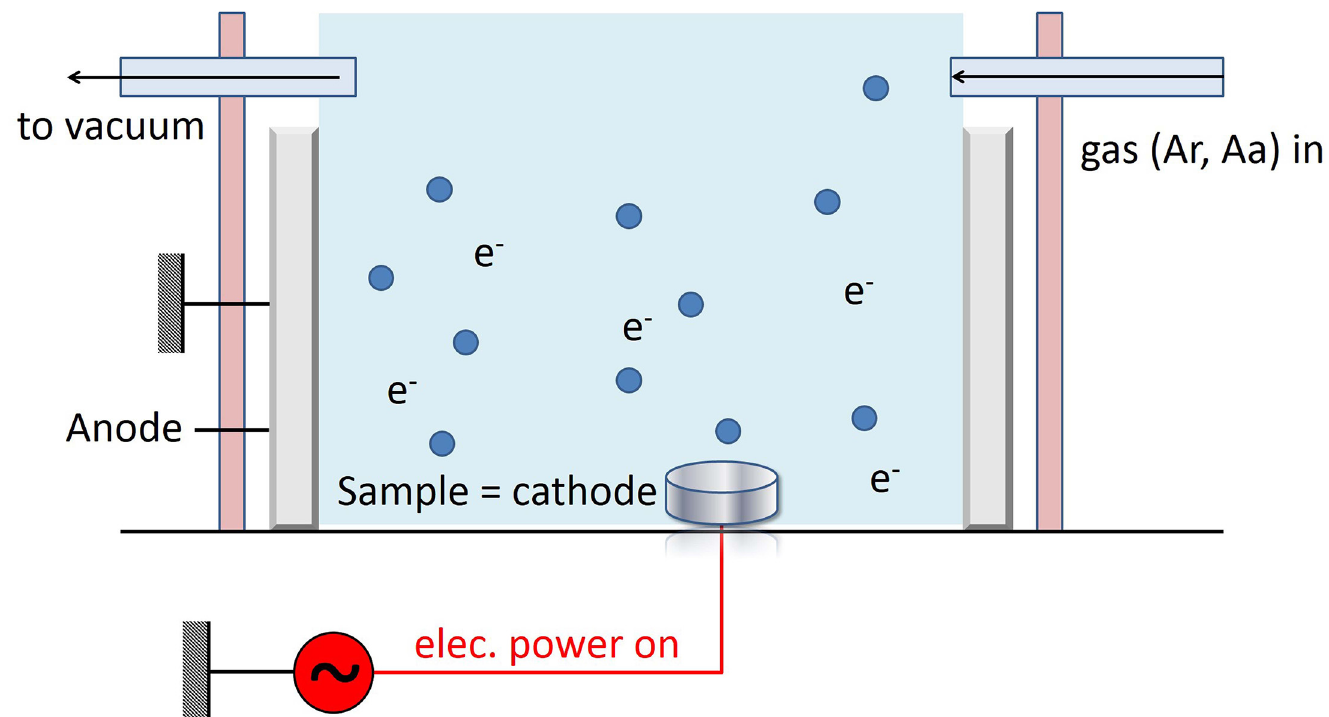
Fig 1. Schematic of the flow discharge plasma system. The blue circles represented the gas ions (argon or allylamine) which were used to modify the titanium surface.